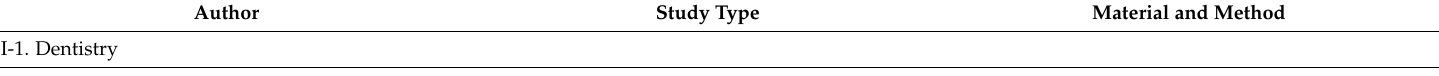
Table 3. Clinical studies of dental implant therapy using